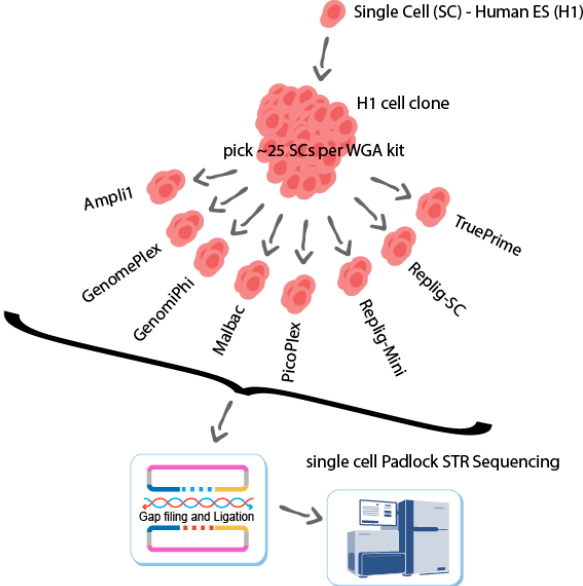
Figure 1. Experimental setup—a clone was generated from a single human ES cell (H1) that is considered normal and without known chromosomal aberrations. The clonal cells were dissociated and picked using the CellCelector (ALS) automated cell picker. The cells were then processed using different single-cell WGA kits (see [16] Methods section). Following single-cell WGA, the DNA samples were processed targeted for STR loci using the DuMIPs pipeline [6,17]. We analyzed the coverage (Figure 2), allelic balance (Figure 3), consistency (Figure 4), amplification noise (Figure 5), and mapping rates (Figure